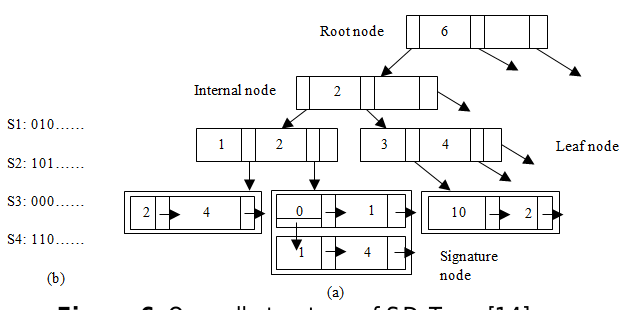
Figure 6 . Overall structure of SD-Tree